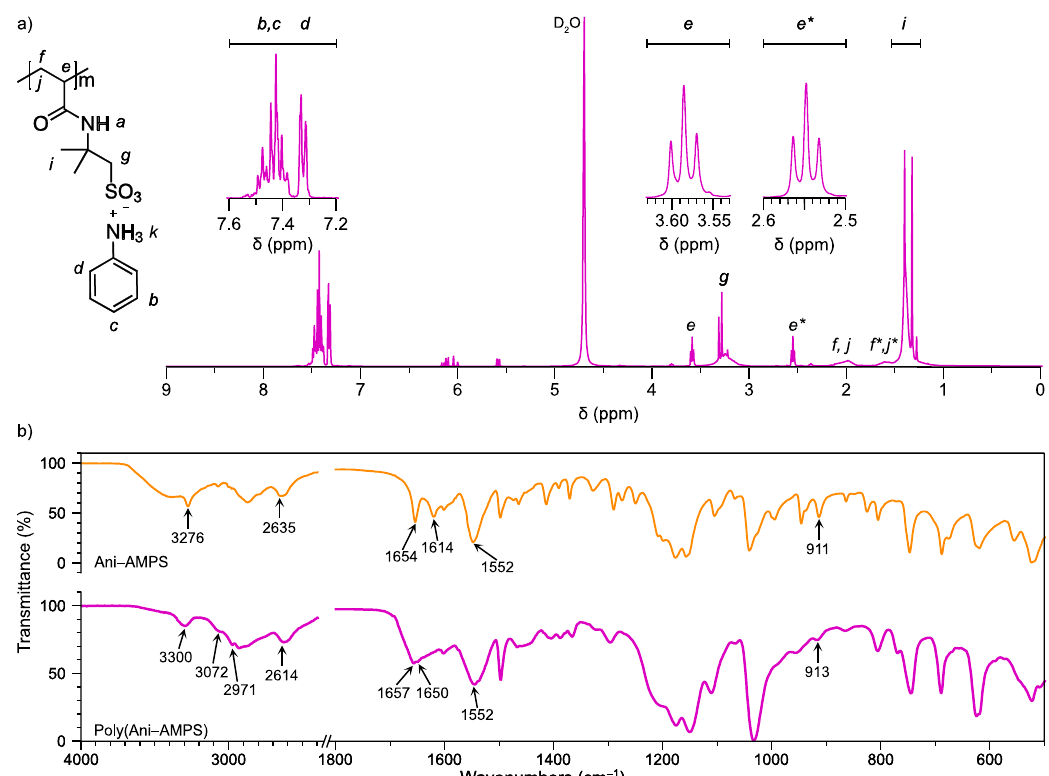
Figure 3. Poly(Ani-AMPS) spectra: ( a ) 1 H NMR (solvent: deuterium oxide) δ 7.80–7.29 (m, 10H), 3.71 (t, J = 6.3 Hz, 1H), 3.49–3.25 (m, 4H), 2.67 (t, J = 6.3Hz, 1H), 2.10 (m, 2H), 1.82–1.55 (m, 2H), 1.53–1.43 (m, 12H); *Equivalent protons with different conformation, and ( b ) FTIR spectra, comparison of the Poly(Ani-AMPS) versus the Ani-AMPS monomer.